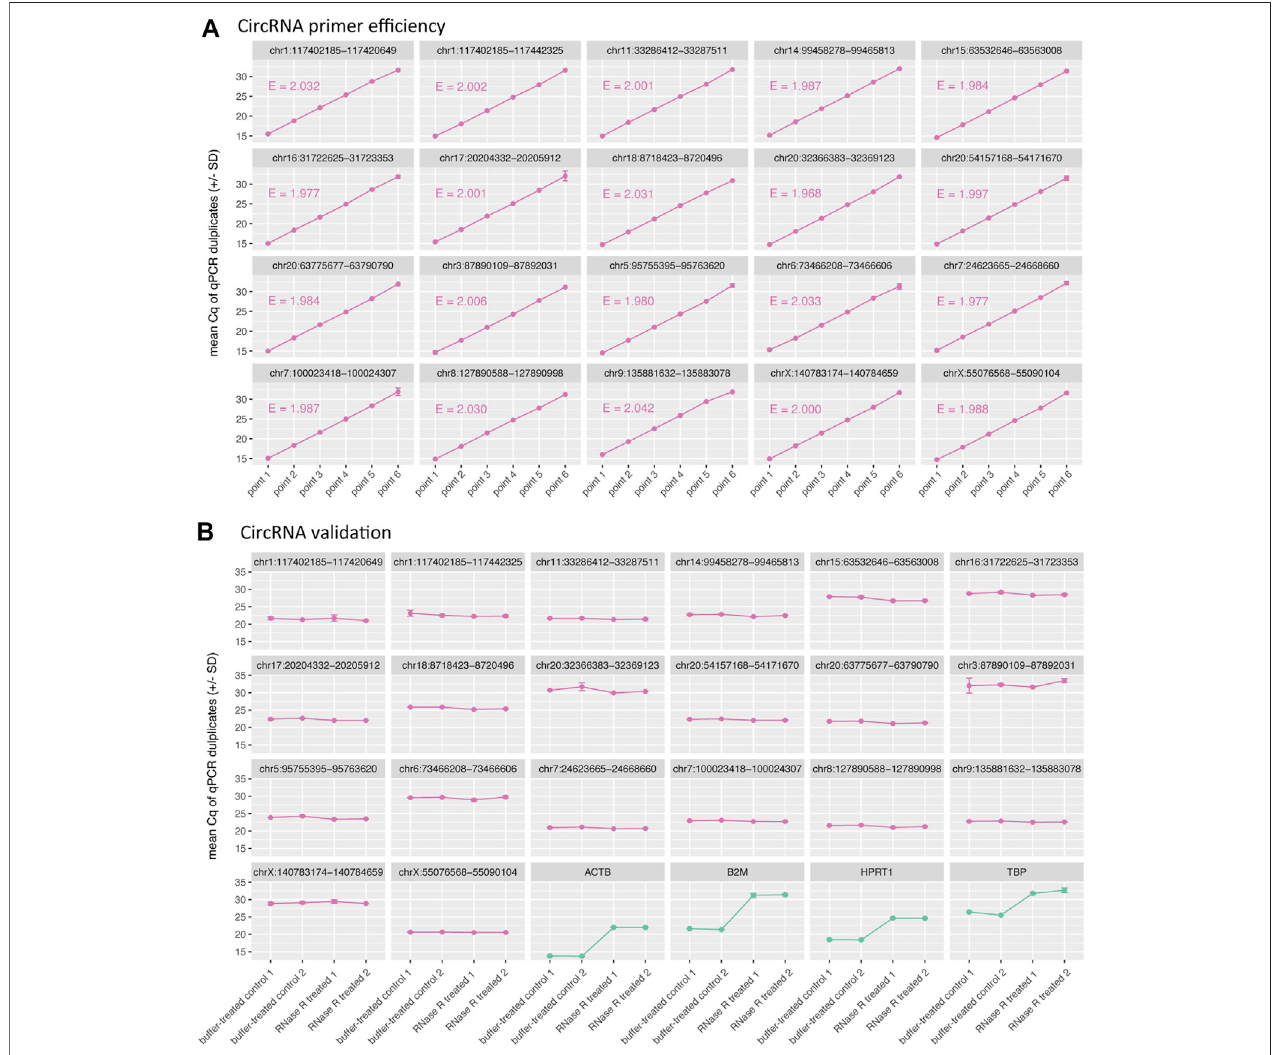
FIGURE 4 | CIRCprimerXL primers are ef fi cient and can validate circRNAs. (A) The ef fi ciency (E) of the primers is assessed using a 6-point 10-fold dilution of a syntheticDNAtemplatepositivecontrol.AllprimersshowedanE-valuebetween1.9and2.1,whichcorrespondstoef fi ciencybetween90and 110%. (B) Theseprimers wherethentestedonSW480totalRNA(twotreatmentreplicates,twoqPCRreplicates).The20circRNAsremainedstable(similarCqvalue)uponRNaseRtreatment,in contrast to the 4 linear control genes, that were degraded (increase in Cq value).